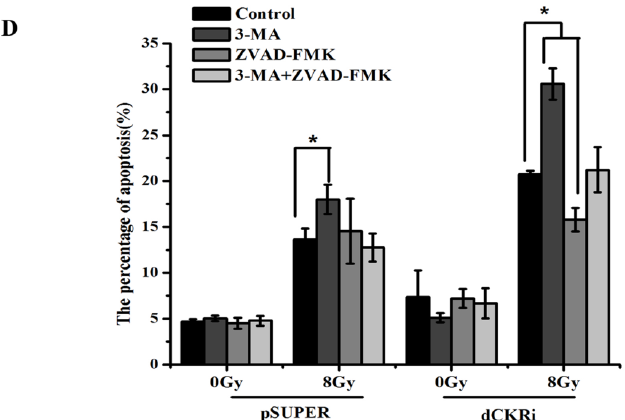
Figure 4. Suppressing autophagy could increase apoptosis induced by IR. ( A ) The pSUPER and dCK knock-down cell lines were incubated with spautin-1 (10 μM) or 3-MA (2 mM) for 1 h, and then treated with IR (8 Gy) for 72 h. Western blot analysis was performed to detect MAPLC3-I/II and GAPDH was used as an internal standard; ( B ) the control and dCK knock-down cells were pretreated with 3-MA (2 mM), spautin-1 (10 μM) or rapamycin (200 nM) for 1 h, and then treated with IR (8 Gy). After 24 h, staining of MDC was detected by flow cytometry. Quantitative analysis of autophagic cells was presented as mean ± SD of three independent experiments. * p < 0.05 versus mock group; ( C ) the pSUPER and dCK knock-down cell lines were incubated with 3-MA (2 mM), ZVAD-FMK (20 μM) or ZVAD-FMK (20 μM) + 3-MA (2 mM) for 1 h, then treated with IR (8 Gy) and incubated for 24 h. Western blot analysis was performed to detect caspase3 and cleaved-caspase3; GAPDH was used as an internal standard; ( D ) the pSUPER and dCK knock-down cell lines were pretreated with 3-MA (2 mM), ZVAD-FMK (10 μM), 3-MA (2 mM) + ZVAD-FMK (10 μM) for 1 h respectively, and then treated with IR (8 Gy). After 48 h, cells were collected, stained with PI and Annexin V-FITC and analyzed by flow cytometry. * p < 0.05 versus control group.